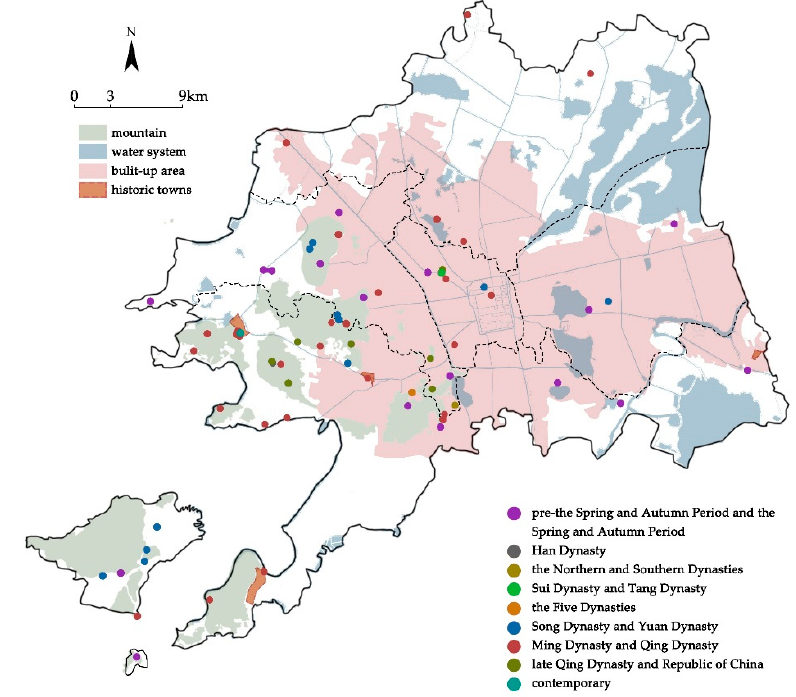
Figure 9. Distribution of relics and tombs.